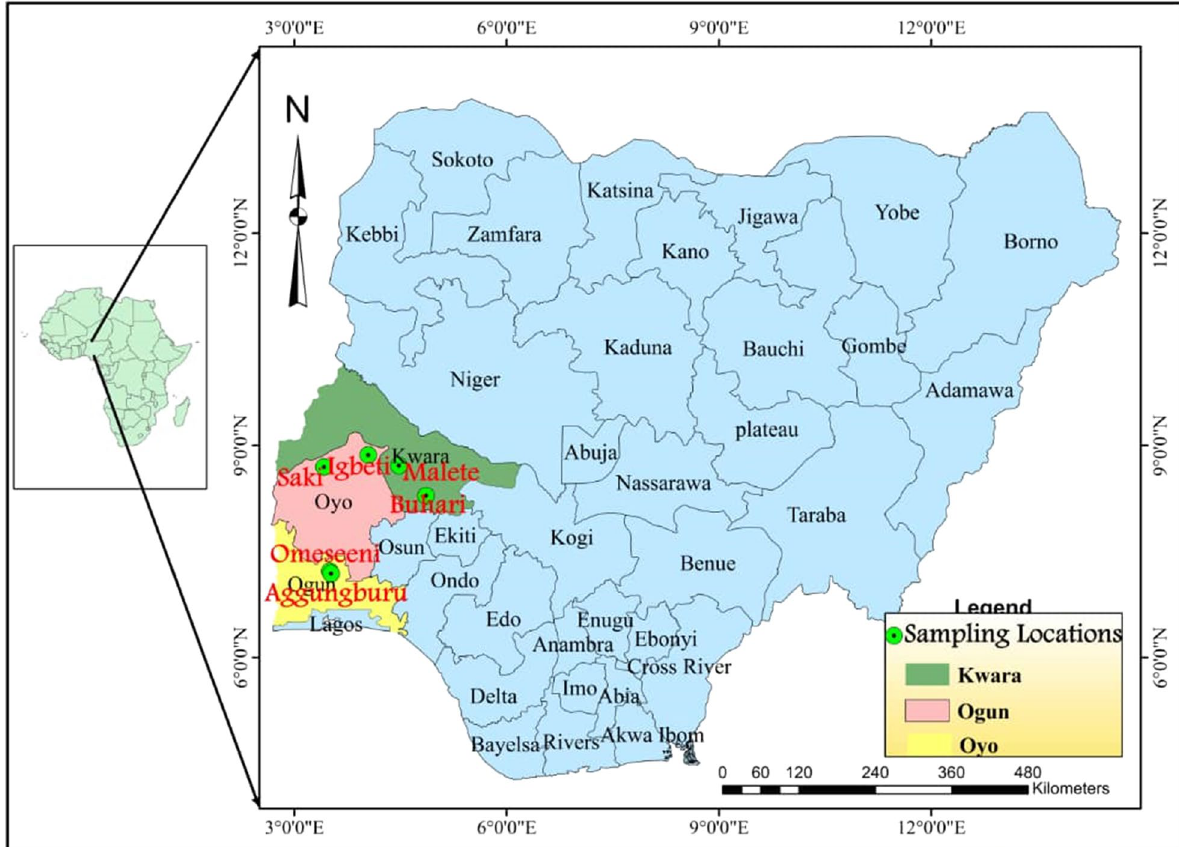
Fig. 1 Map showing the study locations